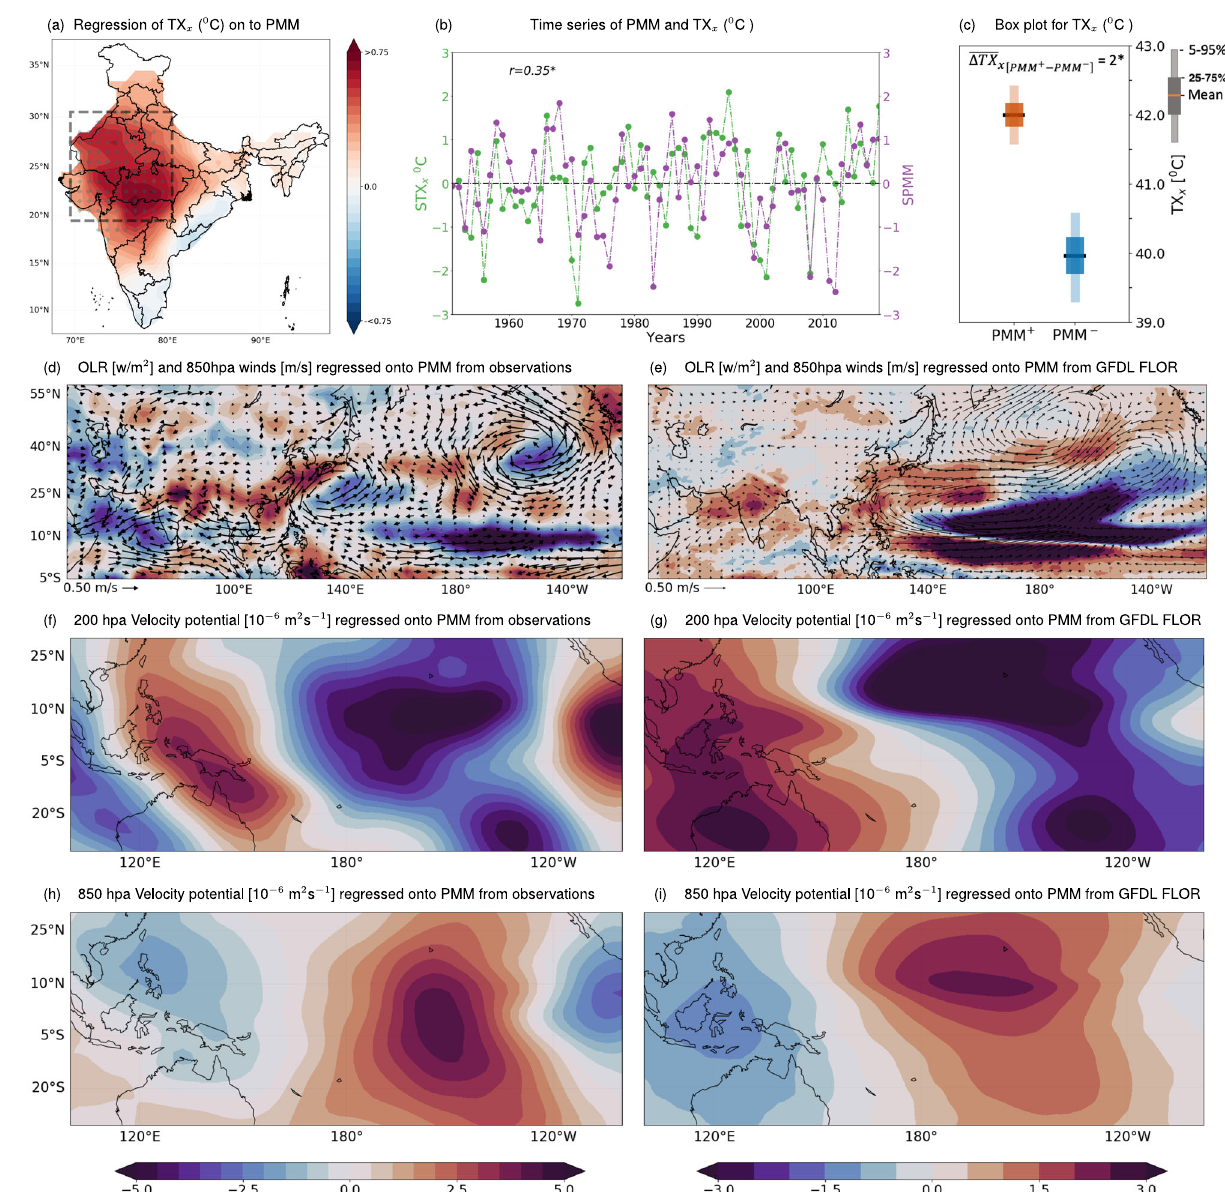
Fig. 2 | Large-scale controls of the Paci fi c Meridional Mode (PMM) on the NCI summer (June) heatwave variability. a Regression of TX x over India onto leading PMM index during the period 1951 – 2019. The dotted areas represent the locations where the slopes are signi fi cant at the 5% level. b Inter-annual variability of the leading PMM index and summer TX x estimated over the NCI region (black rec- tangular box in the panel a ), with variability being represented in terms of their standardized scores. We noticea signi fi cant positive correlation betweenthe PMM index and summer TX x variability across NCI, ( p -value ≤ 0.05; represented with '*' symbol). The years with standard deviation>(<) 1 ( − 1) from this